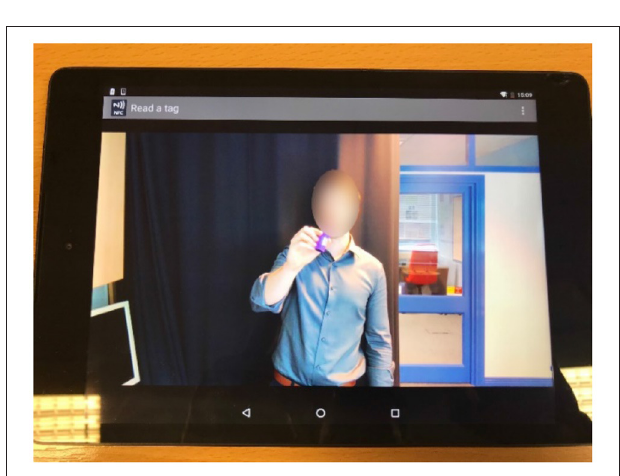
FIGURE 2 | Instructional video activated by NFC tag to demonstrate installation of PCRC SHIB sensors.